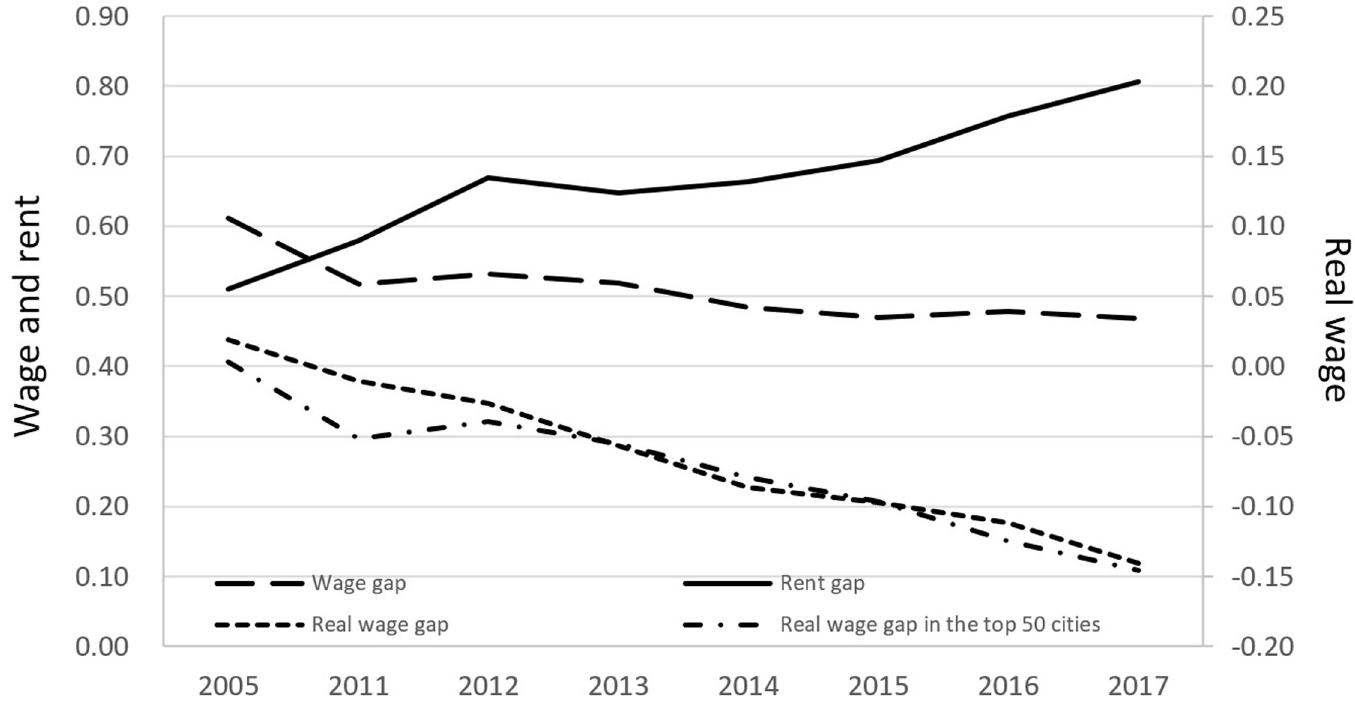
Fig 7. Changes in wages, rents, and real wages of migrants from 2005 to